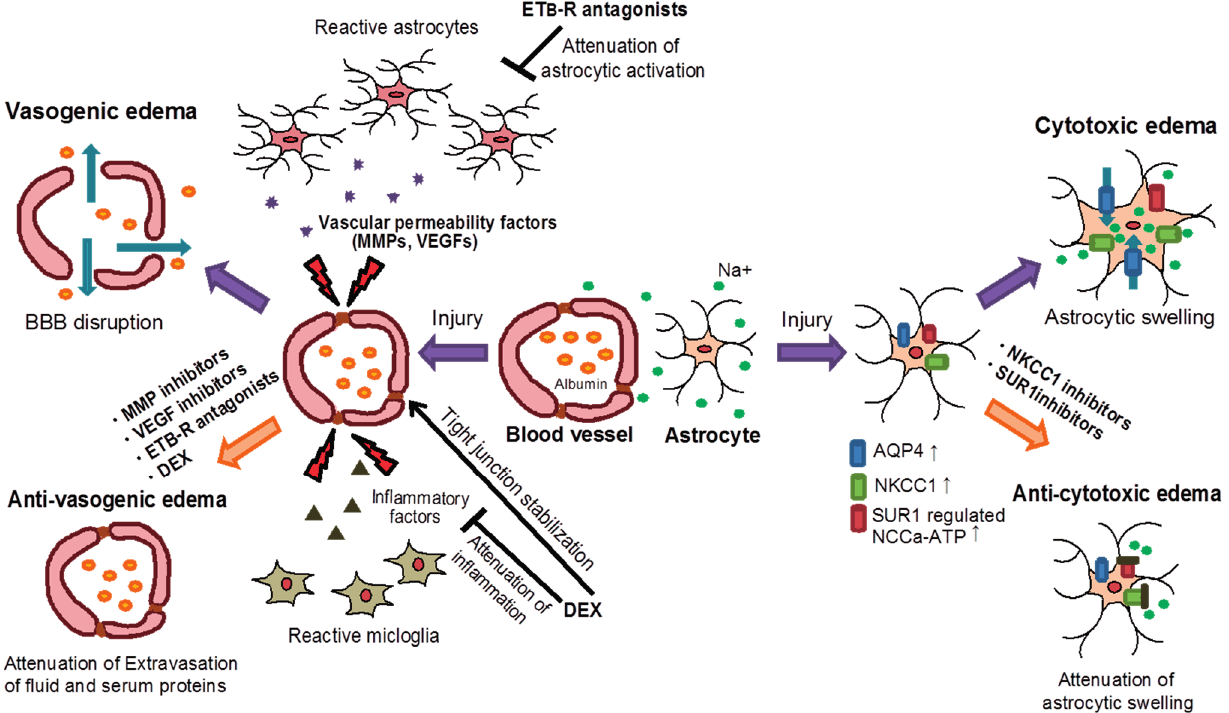
Figure 3. Involvement of key molecules and effects of candidate anti-edema drugs in brain edema. After brain insult, matrixmetalloproteinases (MMPs) and vascular endothelial growth factors (VEGFs) are increased, causing disruption of tight junctions and BBB hyperpermeability. ETB-R antagonists attenuate the activation of astrocytes and production